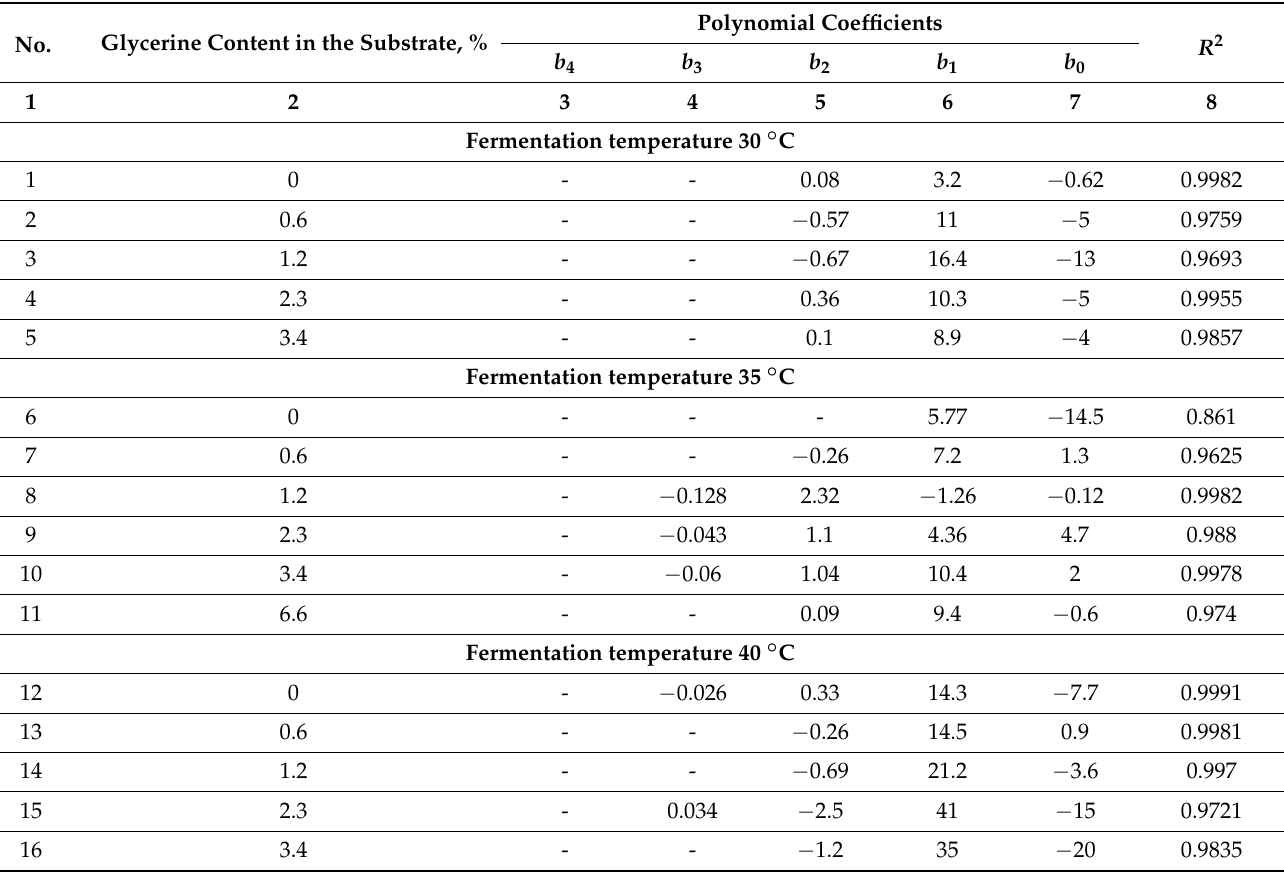
Table 2. Polynomial coefficients describing the accumulated biogas yield during the fermentation of cattle manure with the addition of crude